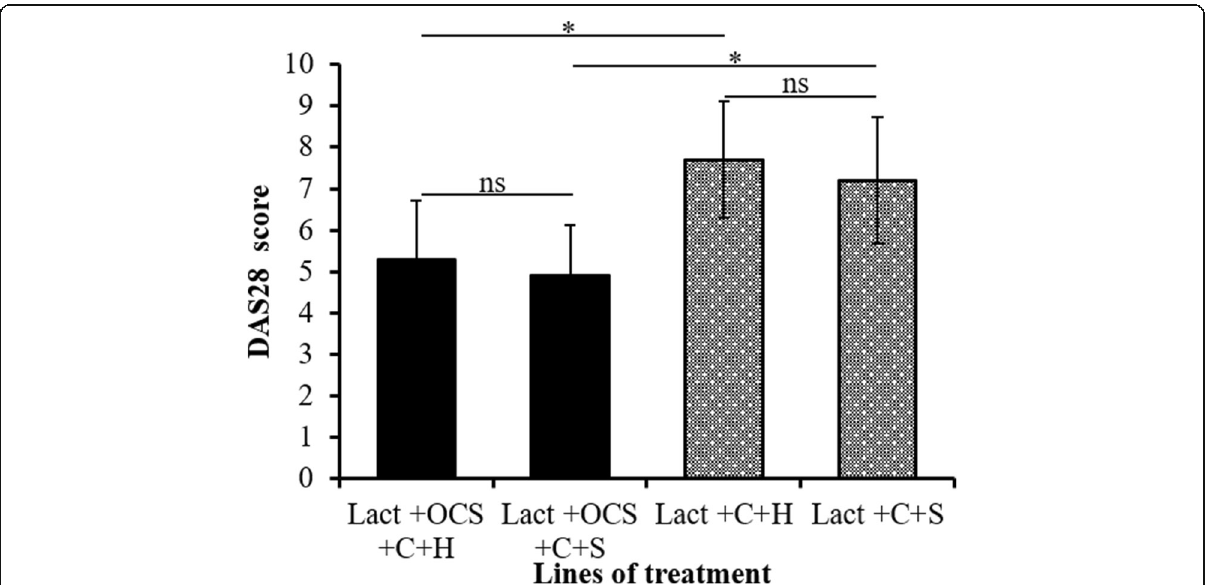
Fig. 4 Effect of different lines of treatment in lactating women on DAS28 score. Where Lac + OCs + C + H, lactating women using OCs and treated by corticosteroids + hydroxychloroquine n = 16. Lac + OCs + C + S, lactating women using OCs and treated by corticosteroids + sulphasalazine n = 6. Lac + C + H, lactating women not using OCs and treated by corticosteroids + hydroxychloroquine n = 19. Lac + C + S, lactating women not using OCs and treated by corticosteroids + sulphasalazine, n = 11. Where * is significant difference at p < 0.05 and ns, non-significant